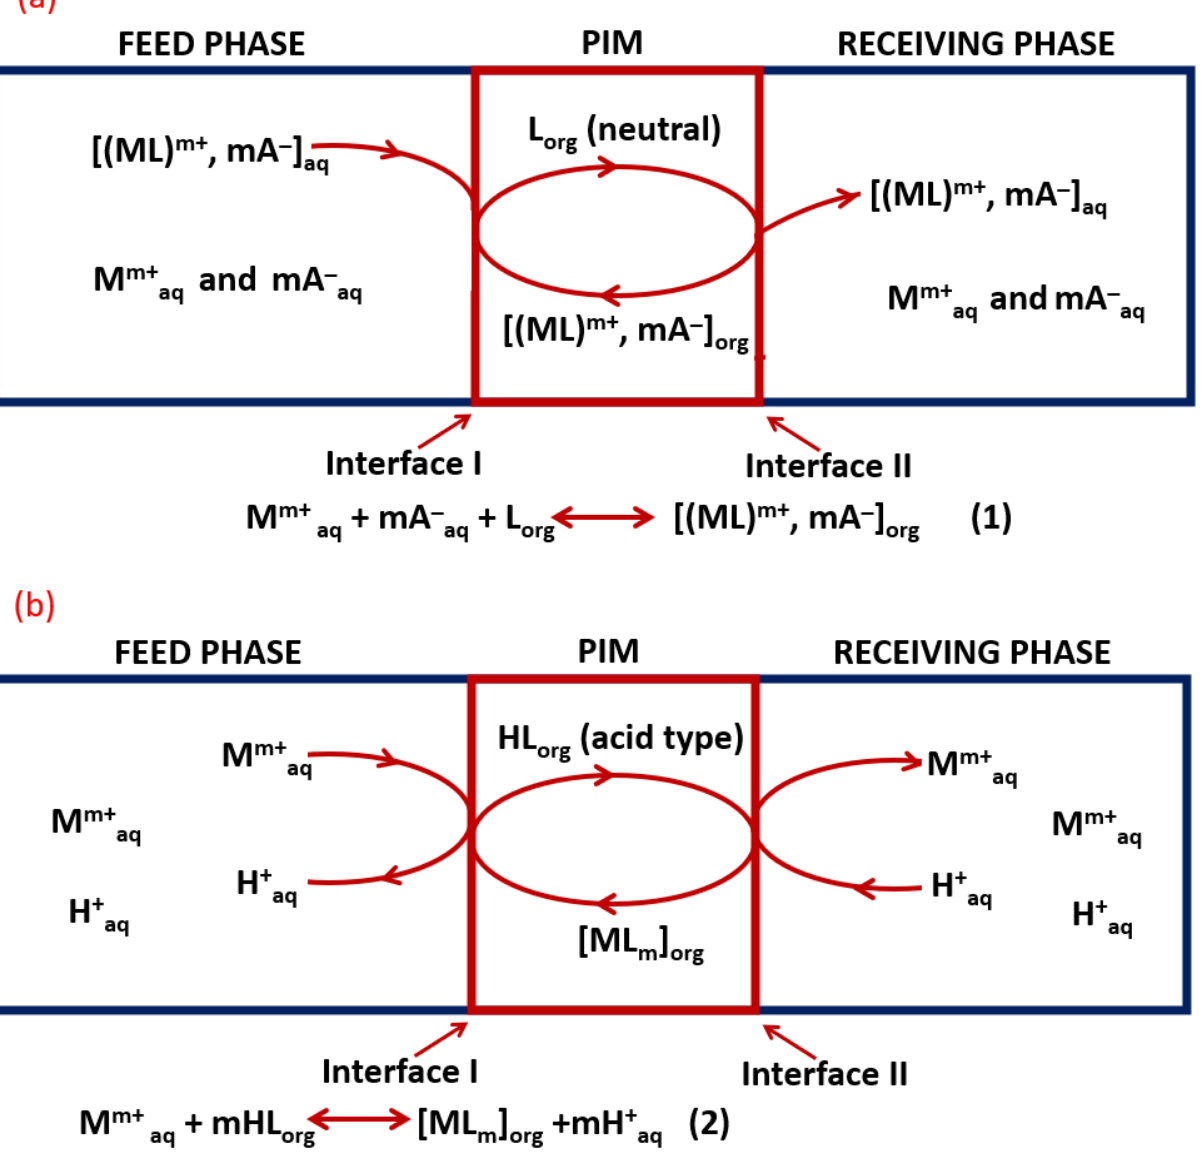
Figure 1. Scheme of transport of metal ions M m+ through PIMs: ( a ) facilitated co-transport (PIM with neutral carrier), ( b ) counter-facilitated transport (PIM with acid type carrier) (prepared on the basis of [33] and references